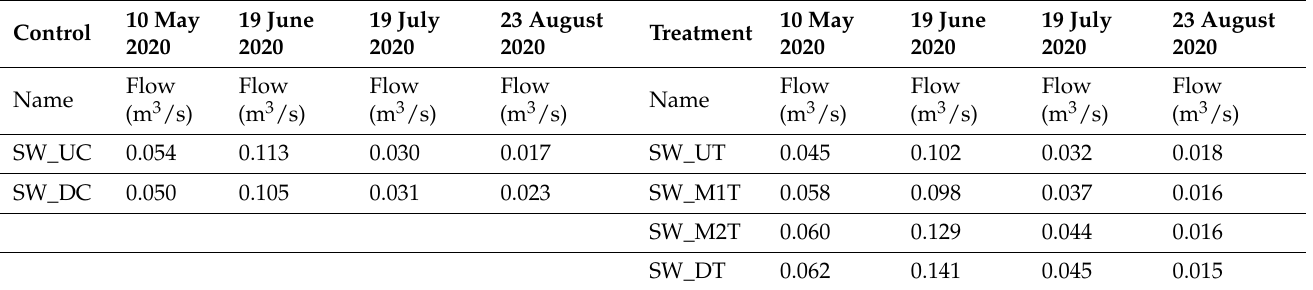
Table 3. Streamflow measurements for control 1 and treatment reaches (Figure 3).